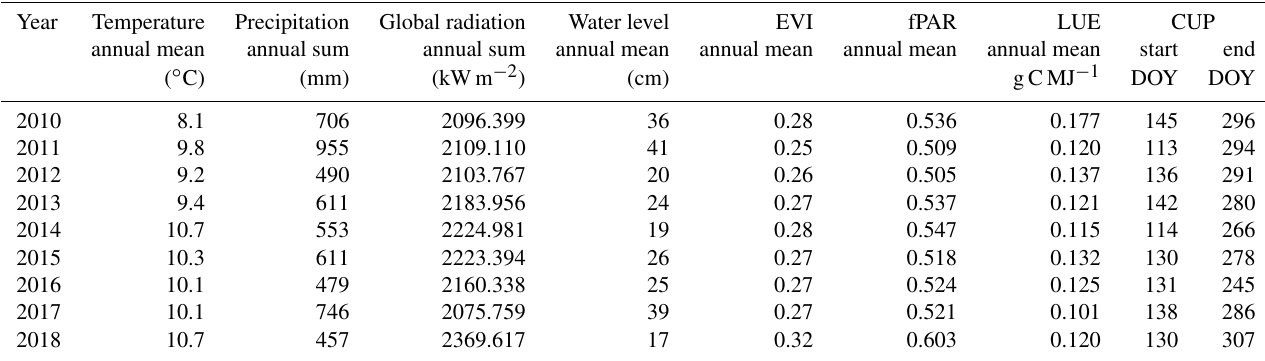
Table 1. Annual means and sums of certain climate and biophysical parameters from the observation period 2010–2018 (EVI: enhanced vegetation index; fPAR: fraction of absorbed photosynthetically active radiation; LUE: light use efficiency; CUP: carbon uptake period; DOY: day of